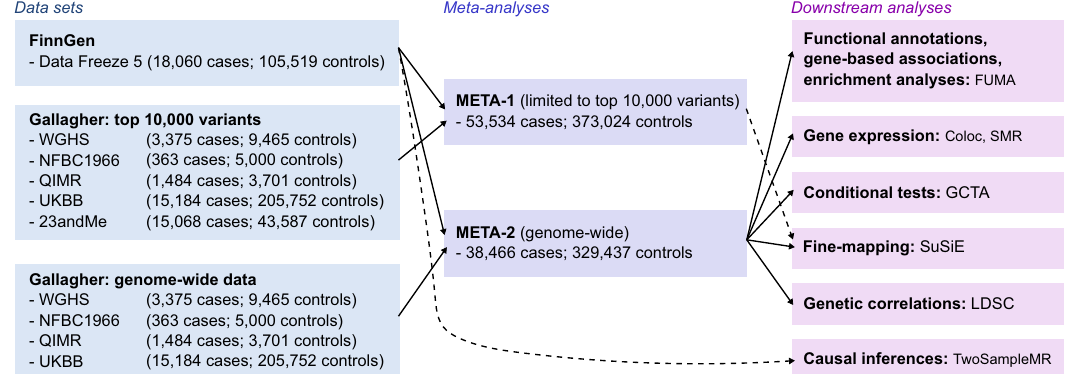
functional annotations, gene-based associations, pathwayenrichment, conditional association tests, fi ne-mapping, and genetic correlations were conducted using genome-wide summary statistics from META-2. In addition, fi ne-mapping was also conducted for the results of META-1. In Mendelian randomisation analyses evalu- ating causal inferences between UL and other, mostly UKBB-based traits, we extracted instruments for UL from the FinnGen-based summary statistics to avoid possible bias from overlapping UKBB samples.